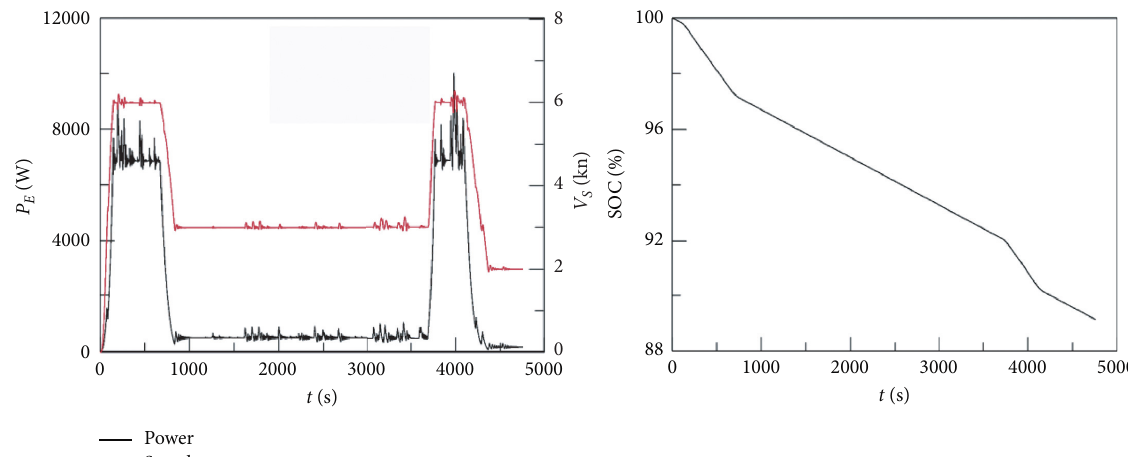
Figure 14: Results of the simulation on Route 2, highlighting speed, power, together with batteries